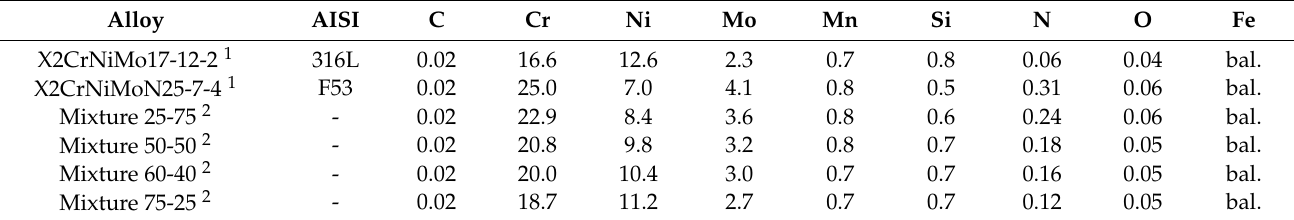
Table 1. Chemical composition of the initial powders and the powder mixtures (in mass